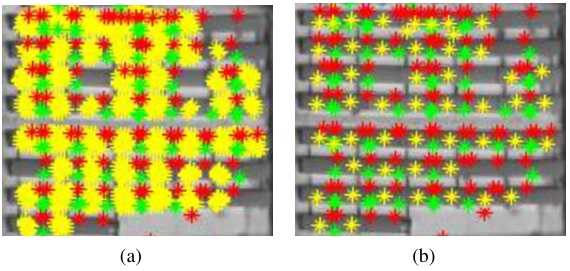
Figure 11. Points extraction. a) Detected upper (red) and lower (green) corner points and estimated centre points (yellow). b) Detected corners and centres after Markov-Chain-Monte-Carlo optimization.